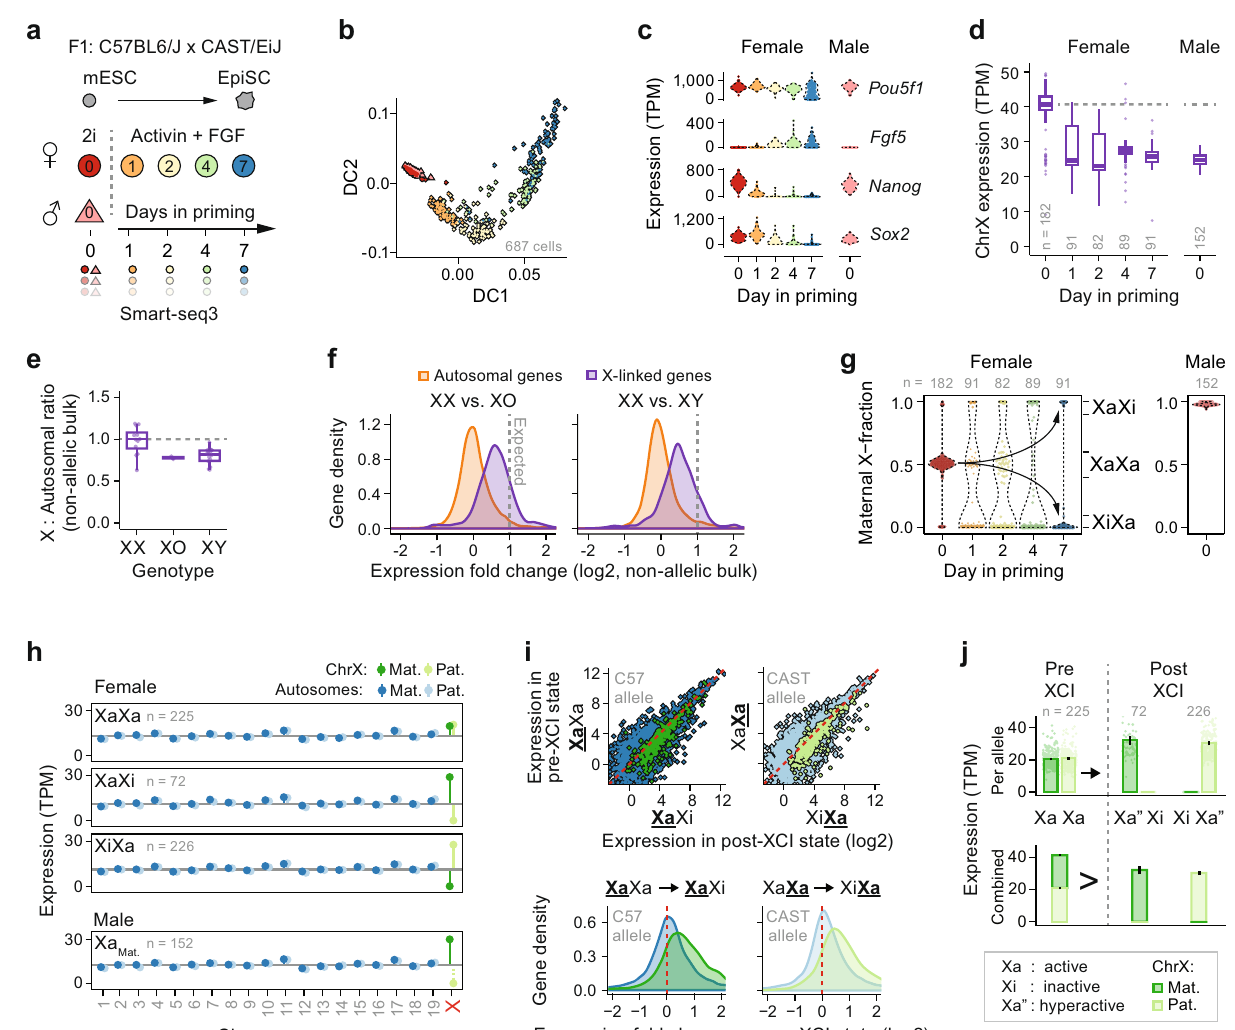
Fig. 1 The state of two active X chromosomes lack X-upregulation. a Schematic overview of the experimental setup. C57BL6/J× CAST/EiJ F1 hybrid mESCs were maintained under 2i conditions and female mESCs were primed into EpiSCs using Activin A and FGF2 for up to 7 days to induce X-inactivation (XCI). Cells were collected at conditions and days of priming as indicated and subjected to scRNA-seq using Smart-seq3. Allelic detection was enabled using strain-speci fi c SNPs in the sequencing data. See Supplementary Data 1 for cell annotations. b Diffusion map showing the differentiation trajectory of mESC priming towards EpiSCs (visualized using the top 1000 variable genes). Cell colors as denoted in panel a . c Violin plots of marker gene expression of pluripotency and differentiation markers Pou5f1 , Fgf5 , Nanog , and Sox2 along EpiSC priming. d Box plots showing total expression of chrX per cell, sex, and timepoint along EpiSC priming ( n = 1158 – 1337 genes). Data are shown as median, fi rst, and third quartiles, and 1.5x inter-quartile range (IQR). e Box plots of X:Autosomal ratios for bulk RNA-seq of mESCs of XX, XO (Turner syndrome), and XY genotypes ( n = 409 – 522 chrX genes). Bulk RNA-seq libraries: XO ( n = 2), XY ( n = 14), XX ( n = 12), each data points shown as a dot. Genes: autosomal ( n = 10,961), X ( n = 405). Data are shown as median, fi rst, and third quartiles, and 1.5x IQR. f Density plot of gene-wise expression fold changes in bulk RNA-seq from female mESCs carrying two X chromosomes (XX) relative to female mESCs lacking one X-chromosome copy (XO) or male mESCs (XY). Dashed lines indicate expected twofold expression fold change, n = same as in d . g Violin plots of fraction maternal X-chromosome expression in cells (dots) along EpiSC priming. Female cells were classed according to allelic X-chromosome expression bias, i.e., XCI state, where each X allele is active (Xa), inactive (Xi), or semi-inactive (Xs, not shown) (right y-axis). h Allele-resolved expression per cell for all chromosomes grouped by sex and XCI status, for autosomes (blue; n = 15,683 – 16,543 genes) and chrX (green; n = 508 – 518 genes), plotted as median ± 95% con fi dence interval. i Expression scatter plots of one allele in XaXa vs. X-inactive state (XaXi or XiXa; C57 and CAST allele active, respectively) in female cells (left) and density plots of expression level fold change of the same allele in XaXi or XiXa state relative to the XaXa state (right). Blue: Autosomal genes ( n = 13,696 – 14,845), green: X-linked genes ( n = 383 – 433). j Bar plots of allele-resolved chrX expression ( n = 508 – 518 genes) in female mESCs. Naïve mESCs with of two active X chromosomes (XaXa) lack XCU (top). As XCI inactivates one allele (Xi) the remaining allele becomes transcriptionally hyperactive (Xa ” ). Biallelic total RNA output of XaXa exceeds that of the monoallelic Xa ” state (bottom). Shown as mean ± 95% con fi dence interval. b , d , g , h , j Number of individual cells per condition shown within